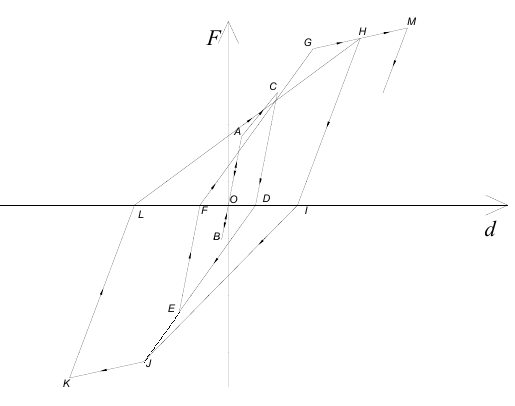
Figure 5. Hysteretic rules for the proposed shear model.